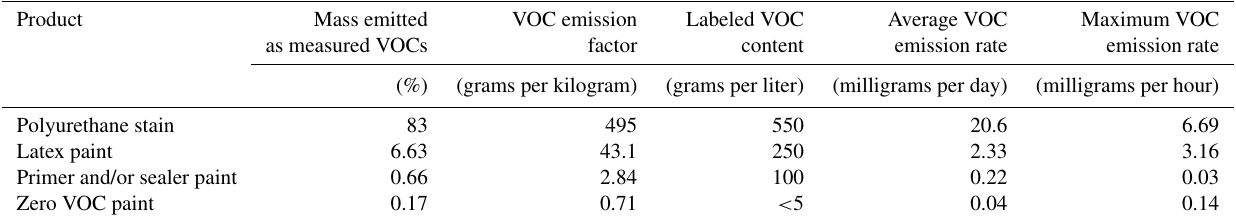
Table 1. Summary of the evaporation experiments for four coating types, including percentage of mass lost as measured VOCs (%), VOC emission factors (grams per kilogram of paint), reported product label VOC content (grams per liter), and the average and maximum total VOC emission rates.